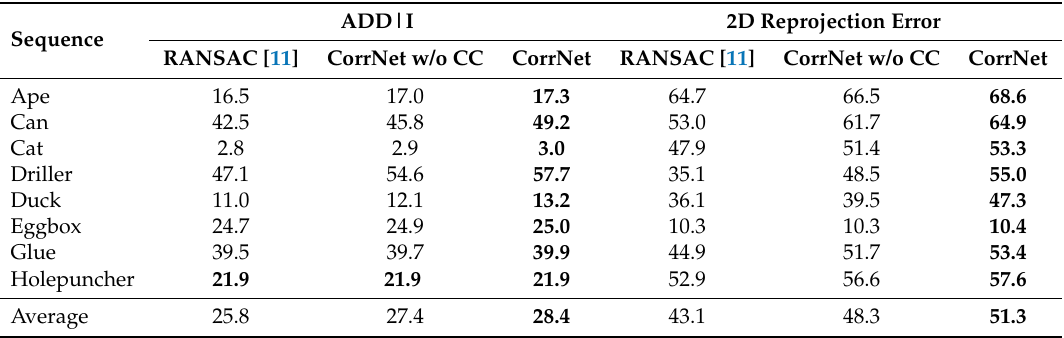
Table 2. Pose estimation results of CorrNet (ours) and RANSAC [11] based method on an Occluded LineMOD dataset [6]. The best results for each term are shown in